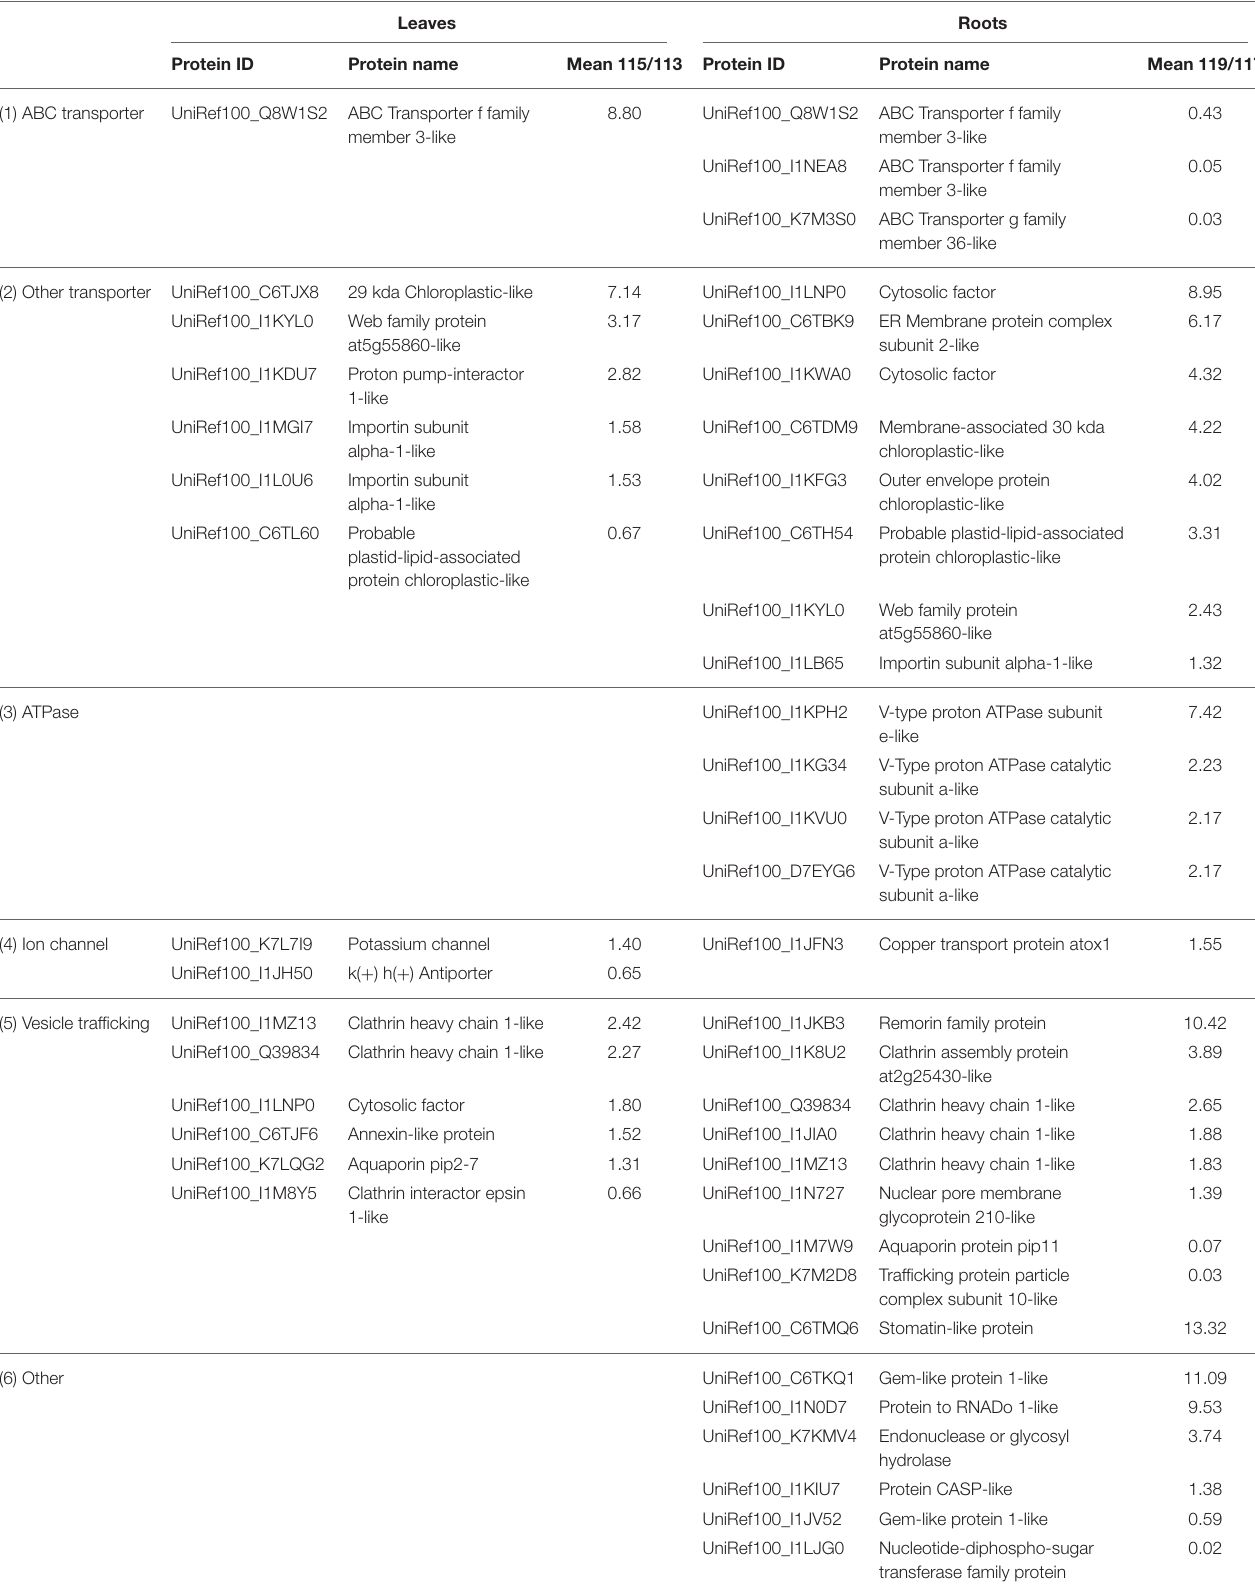
TABLE 2 | Membrane and transport-related proteins differentially expressed under salt stress in soybean leaves and